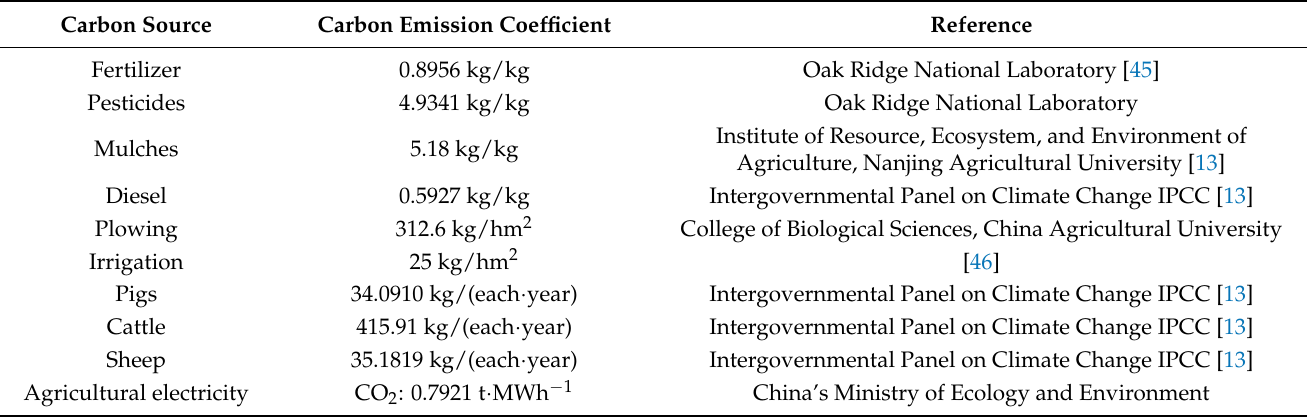
Table 1. Carbon emission coefficient